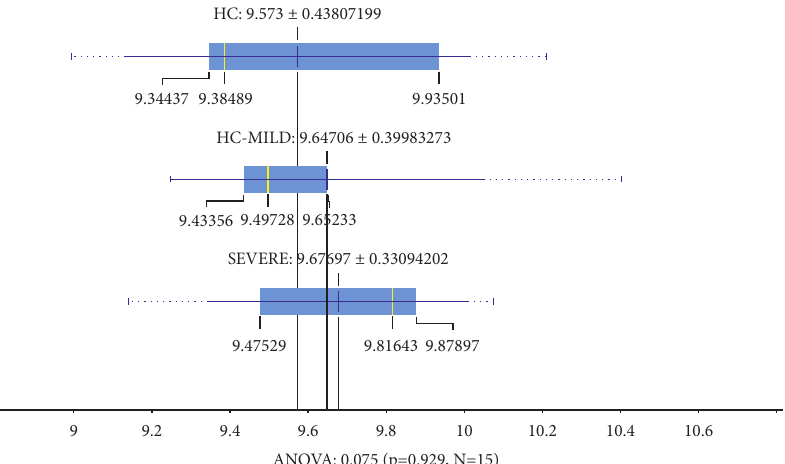
Figure 12: The mean TBK1 expression in the SEVERE and MILD-HC groups not significantly different ( p ≤ 0 . 01 ) .